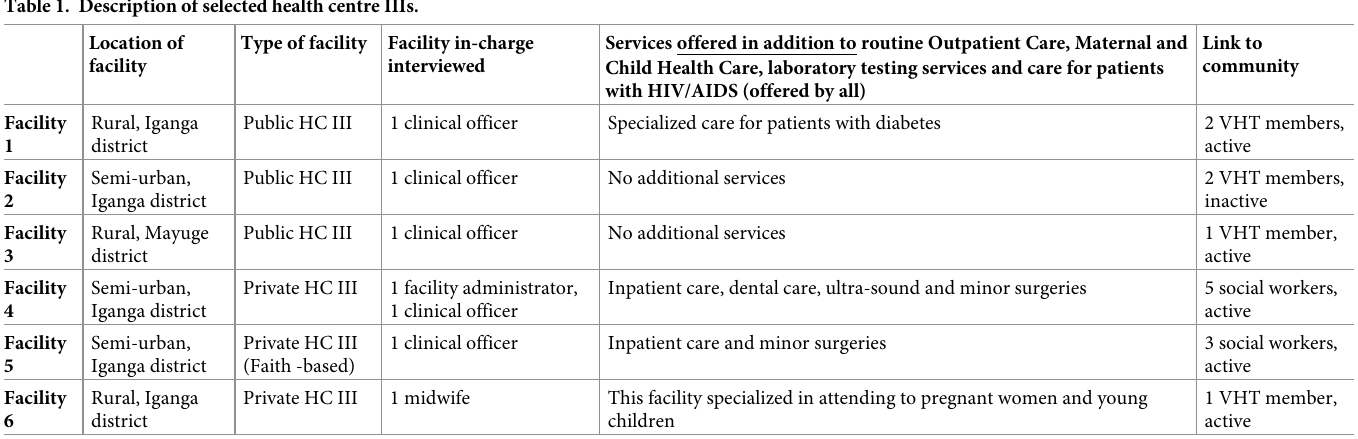
Fig 1. Combined frameworks used in this study for exploring stakeholder perceptions regarding quality and patient-centered care. https://doi.org/10.1371/journal.pone.0221649.g001 Table 1. Description of selected health centre